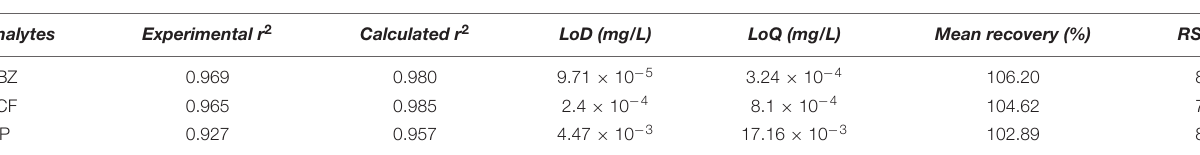
TABLE 2 | Method validation parameters.